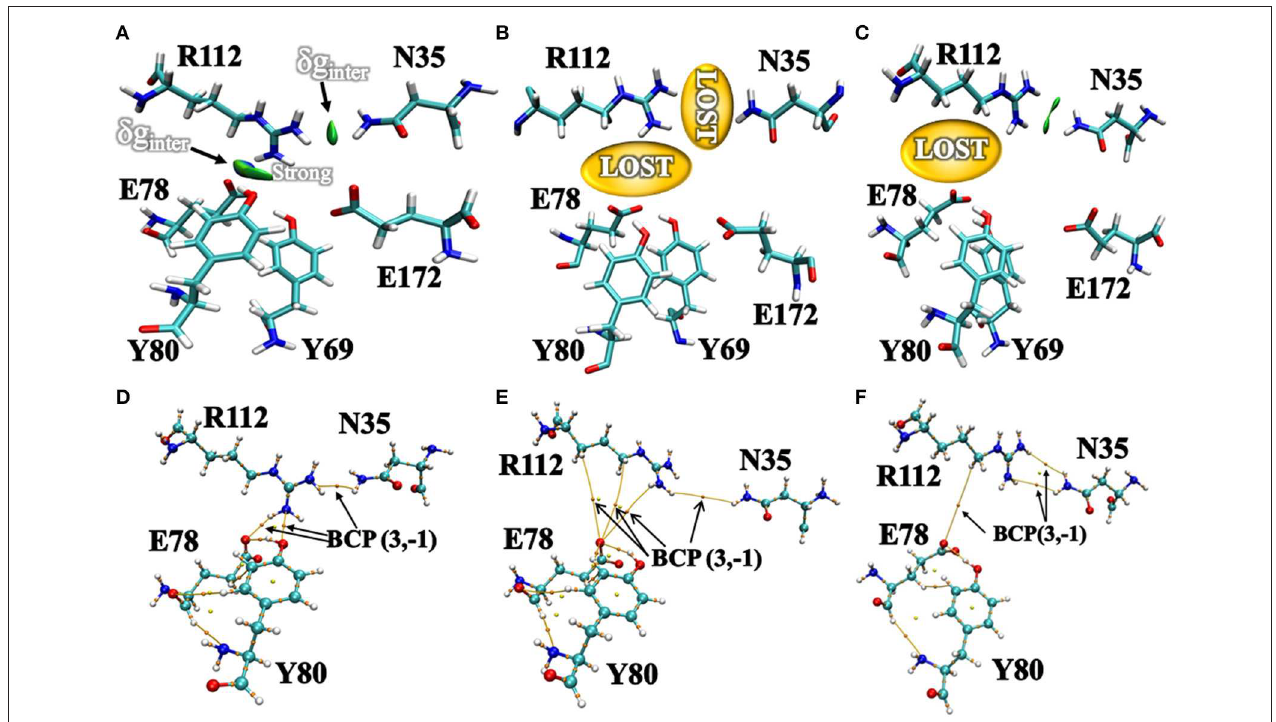
FIGURE 6 | Intermolecular interactions between “gate” residues and active site residues. (A) BaxA; (B) DS241; (C) DS428. The blue represented a strong attraction, and red denoted a strong repulsion. All isosurfaces were colored according to a BGR (blue-green-red) scheme over the electron density range − 0.05a.u. < sign( λ 2 ) ρ < 0.05a.u. Bond critical points (BCPs, small orange spheres) using AIM analysis for different models (D) BaxA; (E) DS241; (F) DS428.